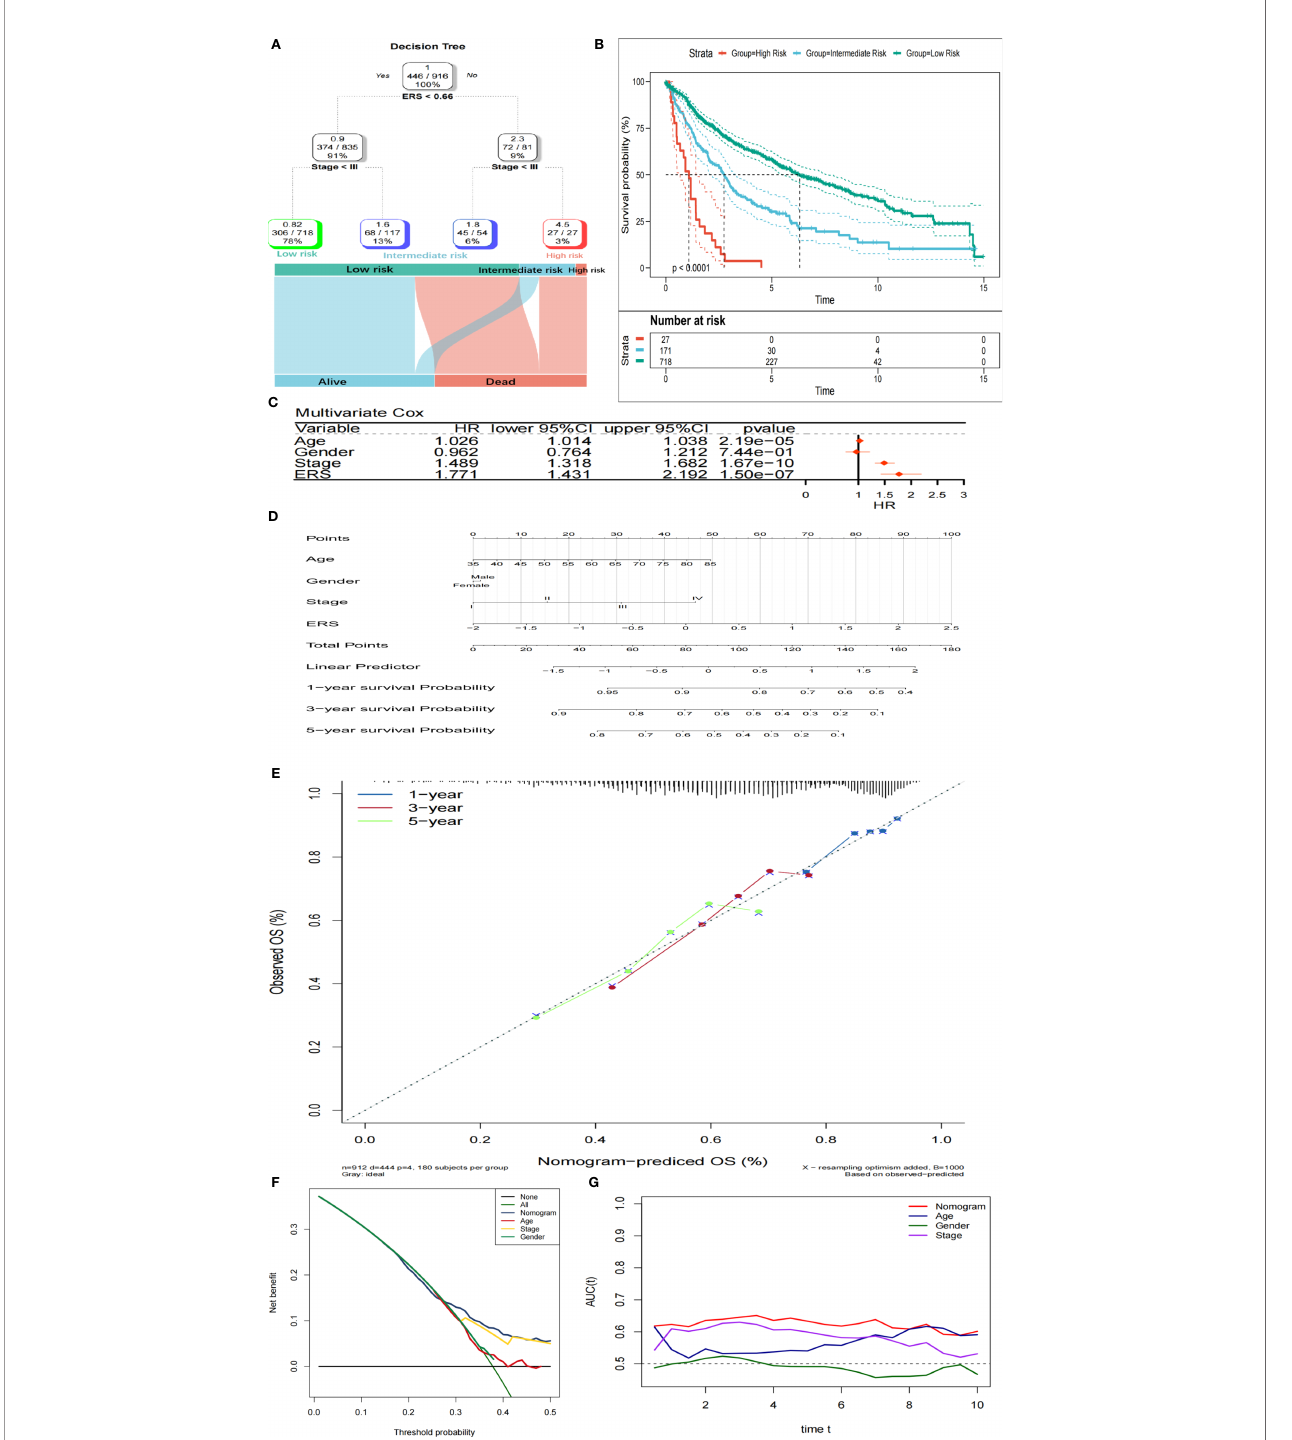
FIGURE 7 | Combination of ERS and clinicopathological characteristics contributes to better risk strati fi cation and survival prediction. (A) Risk strati fi cation was improved by constructing a decision tree. (B) Kaplan-Meier analysis showed noticeably different prognoses of different risk strata. (C) In the whole cohort, ERS was the most important risk factor for OS. (D) Risk assessment of individuals was quanti fi ed by constructing a nomogram. (E) Calibration analysis revealed high accuracy of survival prediction. (F) DCA analysis indicated that nomogram has the optimum decision bene fi t under most thresholds. (G) tROC analysis demonstrated that the nomogram was the most stable and powerful indicator for OS among all the clinical